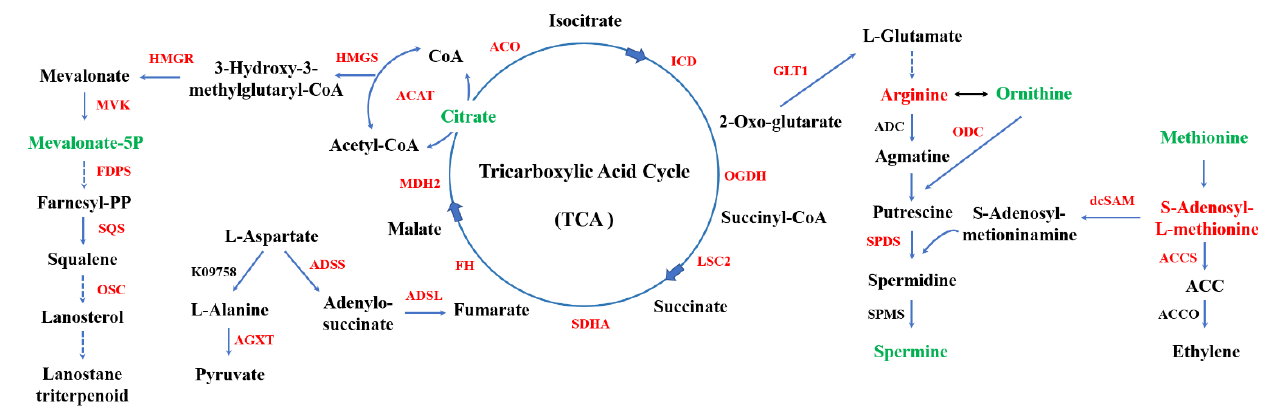
Figure 5. The expression pattern of genes and metabolites involved in key metabolism pathway . HMGS, hydroxymethylglutaryl-CoA synthase; HMGR, 3-hydroxy-3-methylglutaryl-coenzyme A reductase; MVK, mevalonate kinase; FDPS, farnesyl diphosphate synthase; SQS, squalene synthase; OSC, lanosterol synthase; ACAT, acetyl-CoA acetyltransferase; AGXT, alanine-glyoxylate transaminase; ADSS, adenylosuccinate synthase; ADSL, adenylosuccinate lyase; ACO, aconitate hydratase; ICD, isocitrate dehydrogenase; OGDH, 2-oxoglutarate dehydrogenase E1 component; LSC2, succinyl-CoA synthetase beta subunit; SDHA, uccinate dehydrogenase (ubiquinone) flavoprotein subunit; FH, fumarate hydratase; MDH2, malate dehydrogenase; GLT1, glutamate synthase; ADC, arginine decarboxylase; ODC, ornithine decarboxylase; SPDS, spermidine synthase; SPMS, Spermine synthase; dcSAM, decarboxylated S-adenosylmethionine; ACC, 1-Aminocyclopropane-1-carboxylate; ACCS, ACC synthase; ACCO, ACC oxidase. The red color indicates up-regulation, green indicates down-regulation, and black indicates not detected.